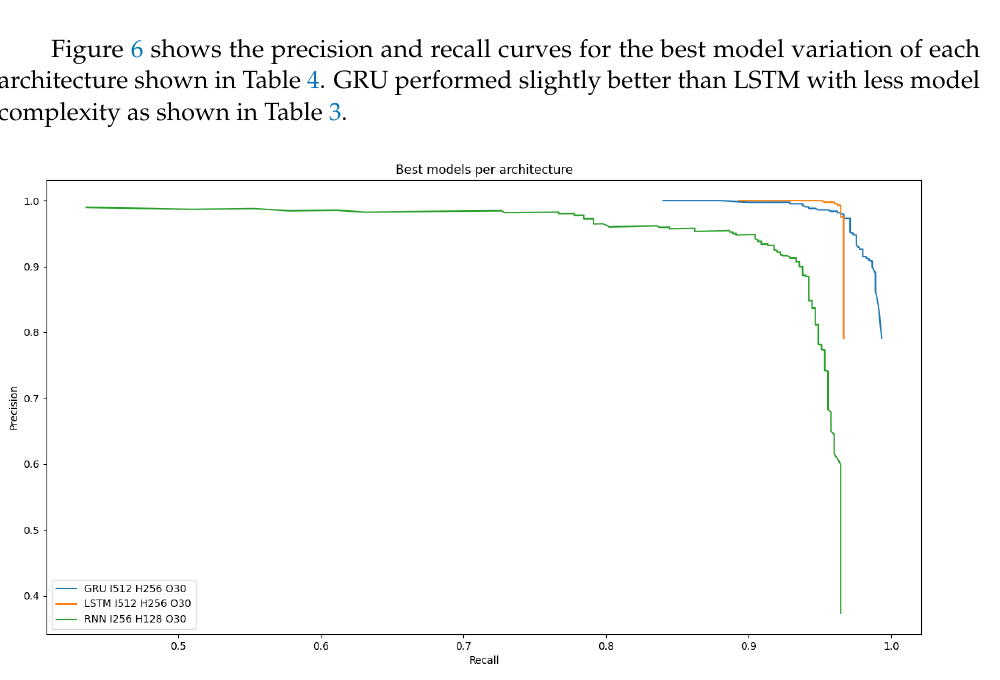
Figure 6. Precision recall curves for the best model of each